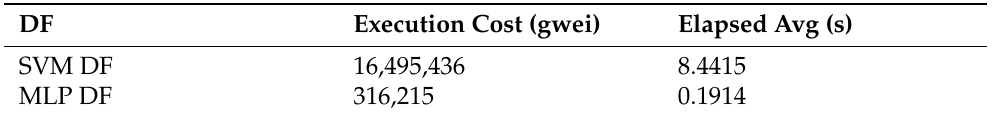
Table 7. DF performance